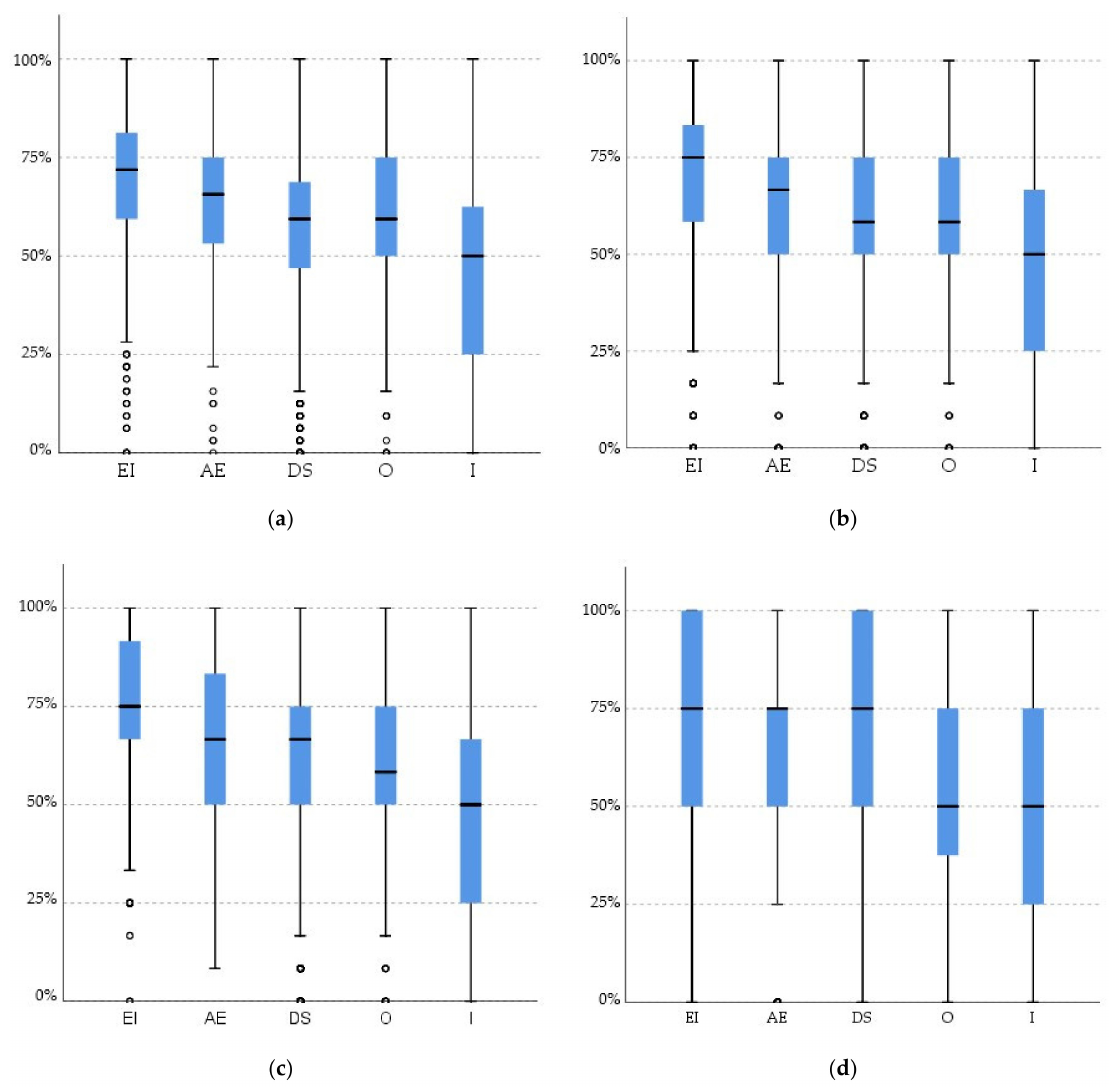
Figure 2. Box plots showing the distribution of the studied factors: ( a ) Information and Knowledge; ( b ) Investments; ( c ) Social Influence; ( d ) Energy Price, by 5 behavioural